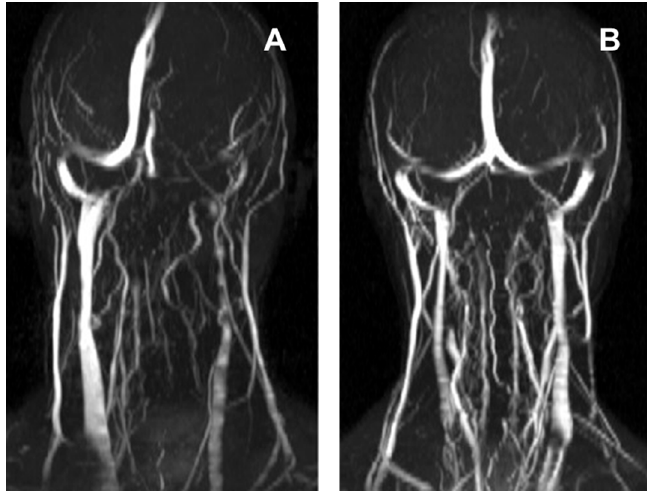
Figure 5. TOF MR venograph of the neck of: ( A ) subject 5010, showing turbulent and reduced flow in the left IJV. The aCSF flow for subject 5010 was predicted from the arterial, venous and cCSF flow rates with an r 2 = 0.587; and ( B ) subject 5006, showing extensive collateral rerouting of venous blood. Notwithstanding this, the aCSF for subject 5006 was strongly predicted by the model (r 2 = 0.894).